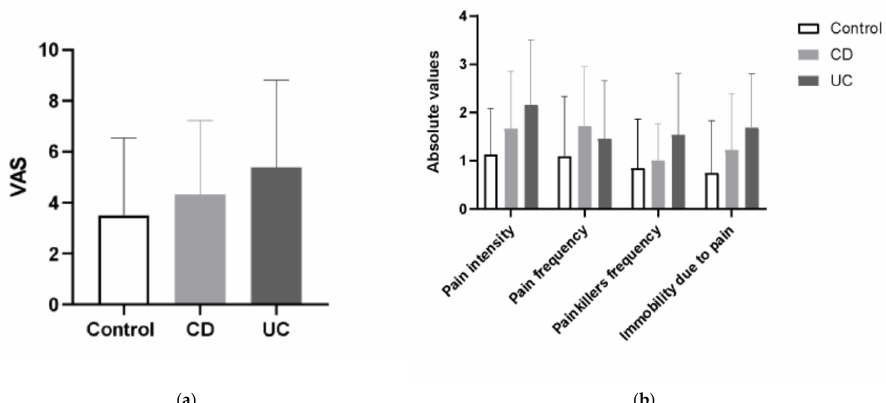
Figure 6. The mean values of visual analog scale (VAS) for quantification of disease-related pain ( a ) and the differences in the values of modified Laitinen Pain Scale ( b ) in controls, CD and UC patients. Also, for all analysed parameters we only found two statistically important correla- tions: between VAS and SOD in UC patients and between Laitinen’s Scale and TBARS in control patients (Figure 7; Figure 8).